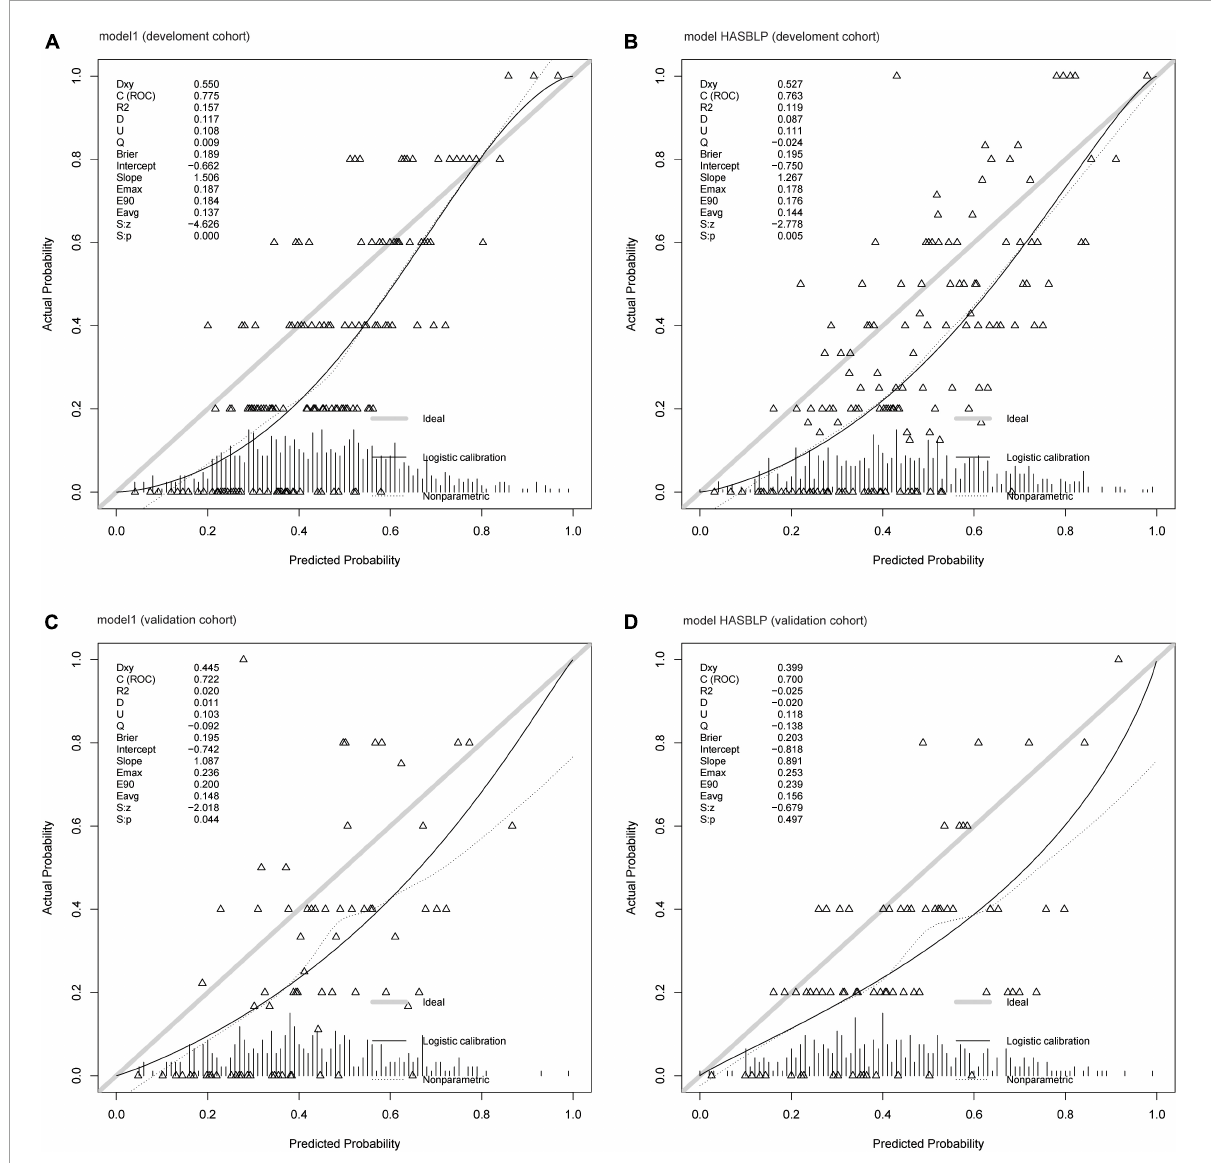
FIGURE3 Calibration curve of prediction models. (A) Model 1 (development cohort); (B) model HASBLP (development cohort); (C) model 1 (validation cohort); and (D) model HASBLP (validation